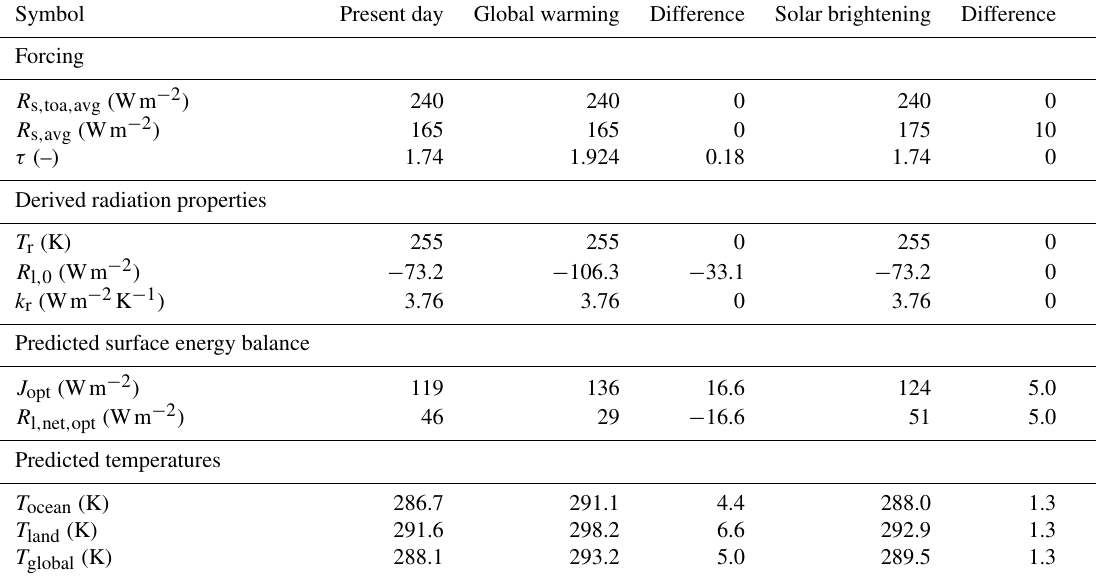
Figure 3. Global mean surface energy balance partitioning predicted from the approach used in this study in comparison to observations of Stephens et al. (2012). The respective values are provided in Table 2. Table 2. Estimates for the global mean forcing, a global warming for a 4 × CO 2 scenario, and a scenario of solar brightening. Symbol Present